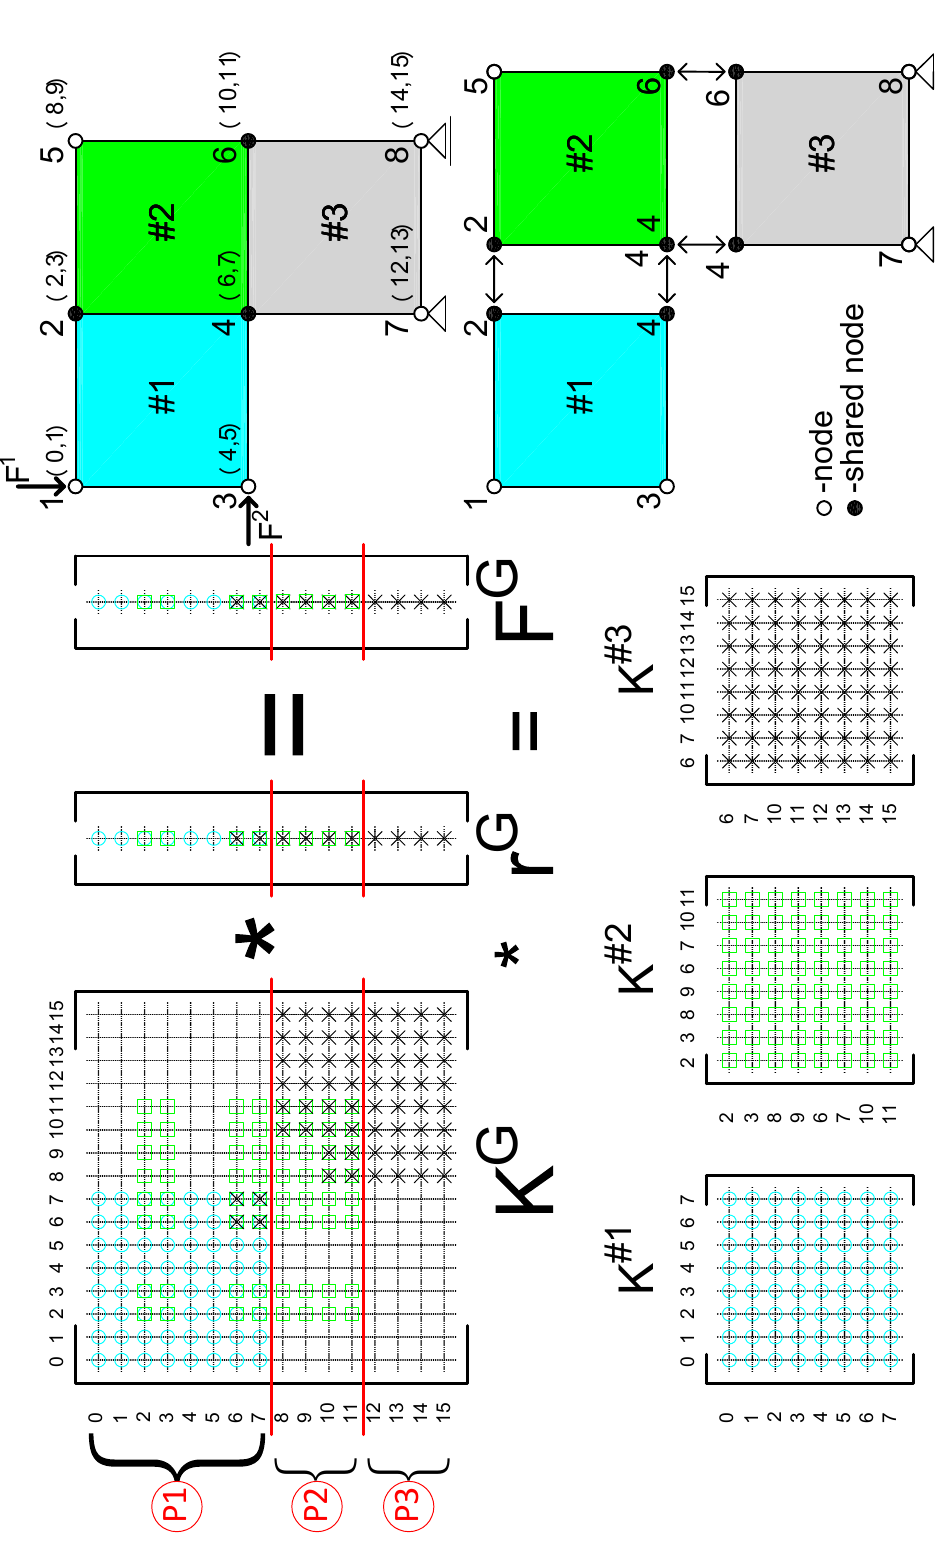
Figure 2. Example of simple problem consisting of three elements distributed into different computing nodes, illustrating the global sparse matrix structure and its